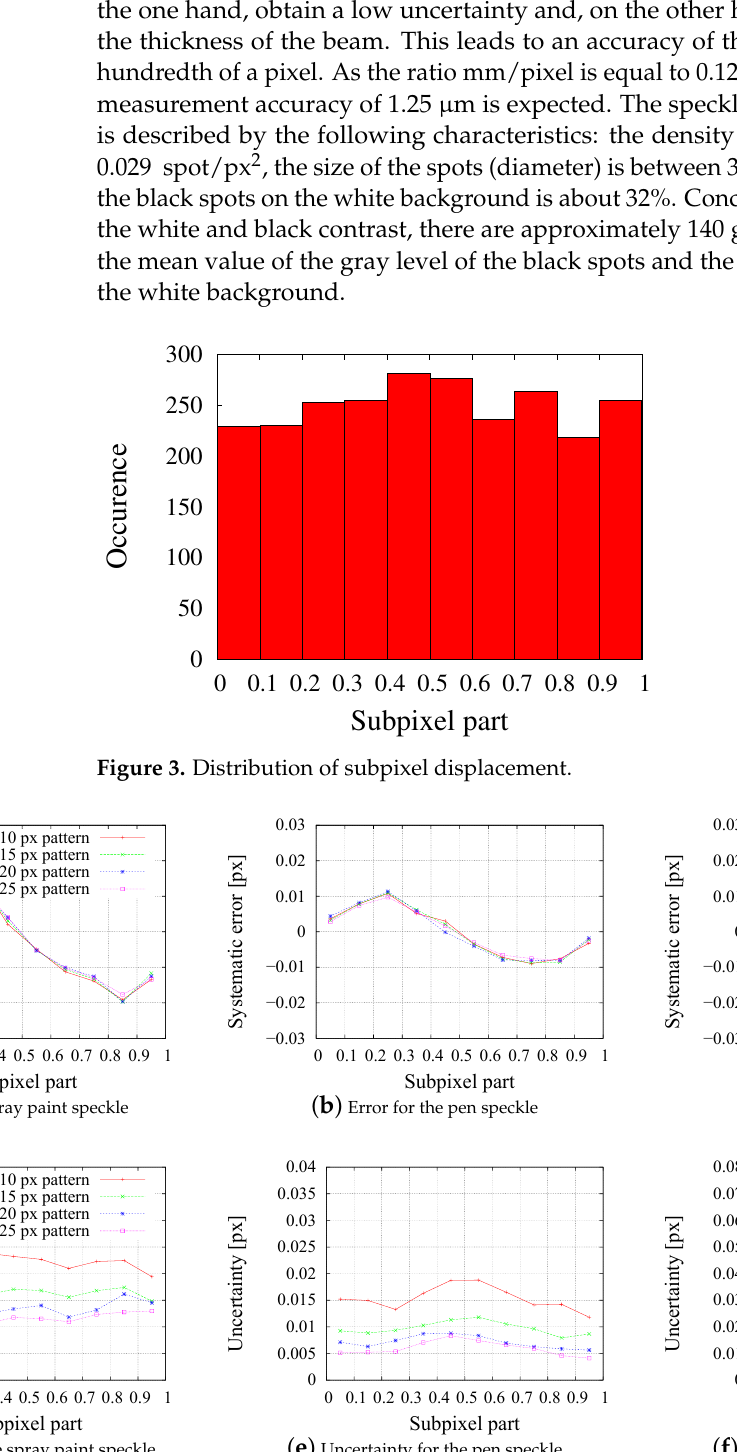
( e ) Uncertainty for the pen speckle Figure 4. Systematic errors and uncertainties for different experimental speckles and different pattern